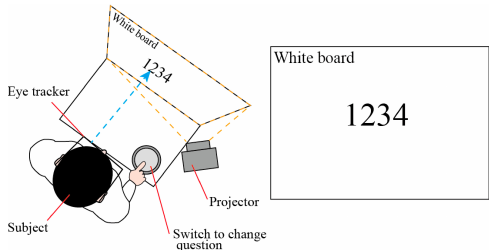
Figure 4. Experimental setup. The subject wears the eye tracker. A number with 3 or 4 digits is shown by the projector on the white board located 1 m in front of the subject. The switch to change the question is placed on the